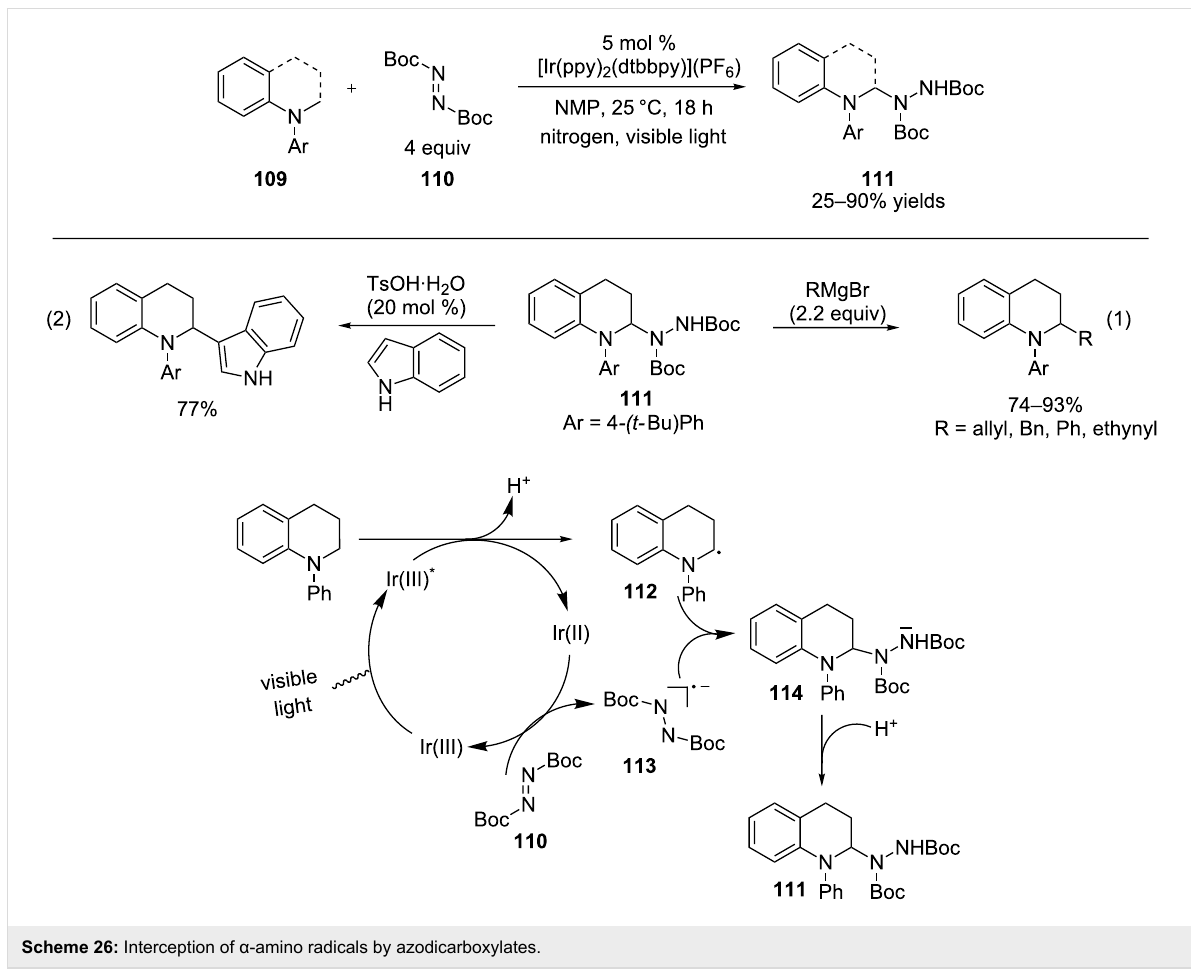
Scheme 26: Interception of α -amino radicals by azodicarboxylates.